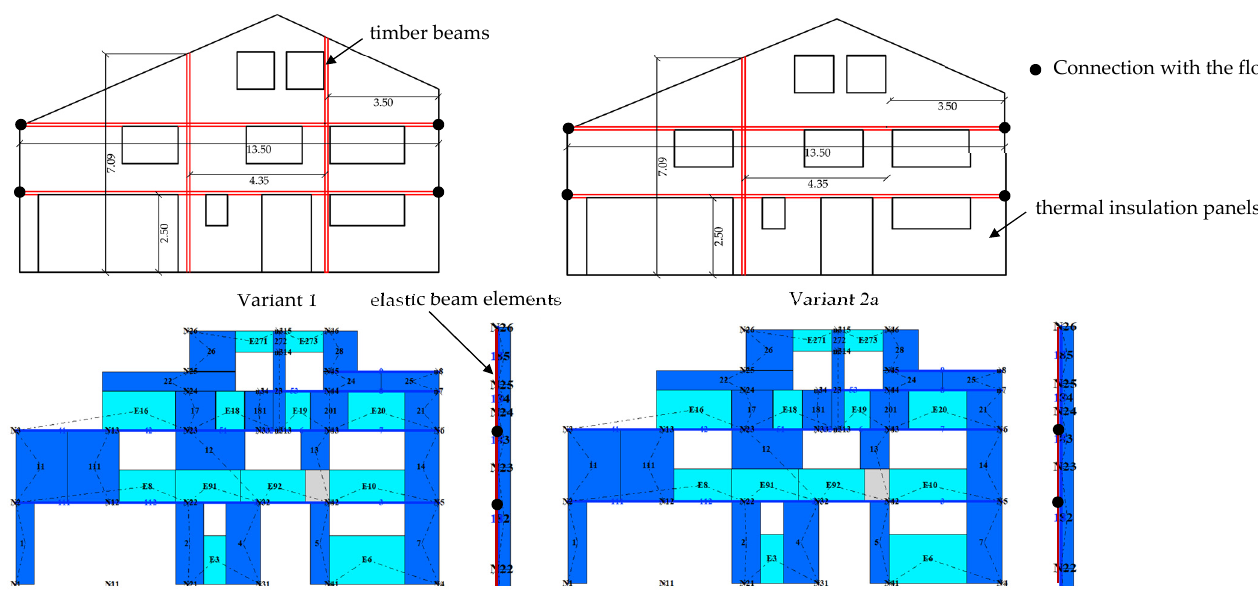
Figure 5. Presentation of the two different variants (Variant 1, Variant 2a) for the seismic retrofitting of the south-east URM facade and the corresponding numerical models that simulate the seismic out-of-plane response of the retrofitted building.